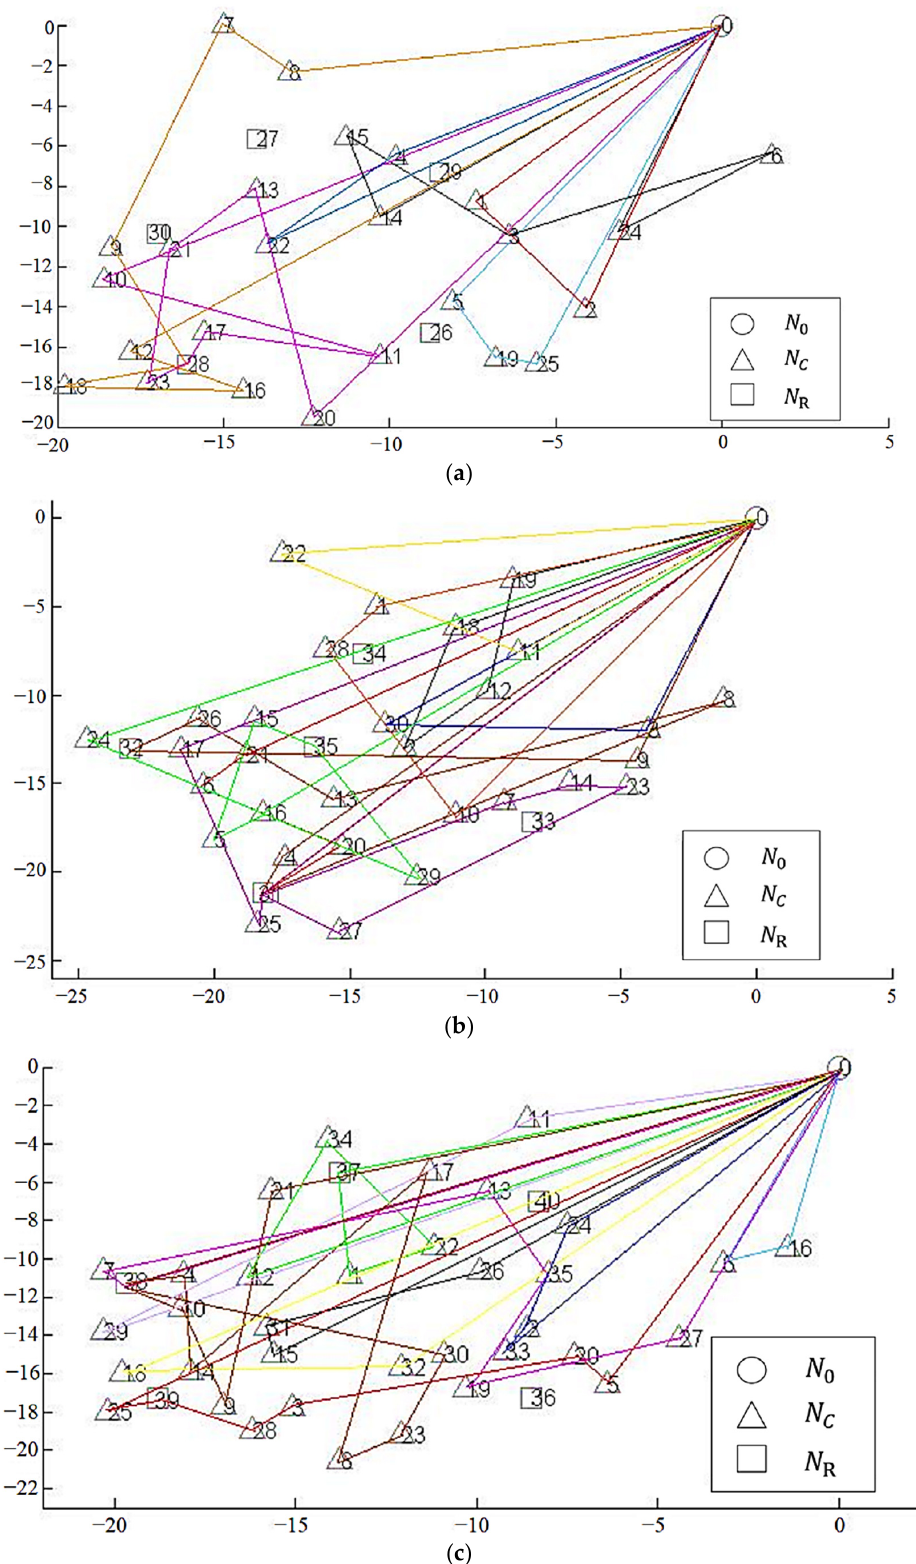
Figure 9. Mapping of optimal delivery paths for EVRPTW-DC: ( a ) Scenario 1; ( b ) Scenario 2; ( c ) Scenario 3.